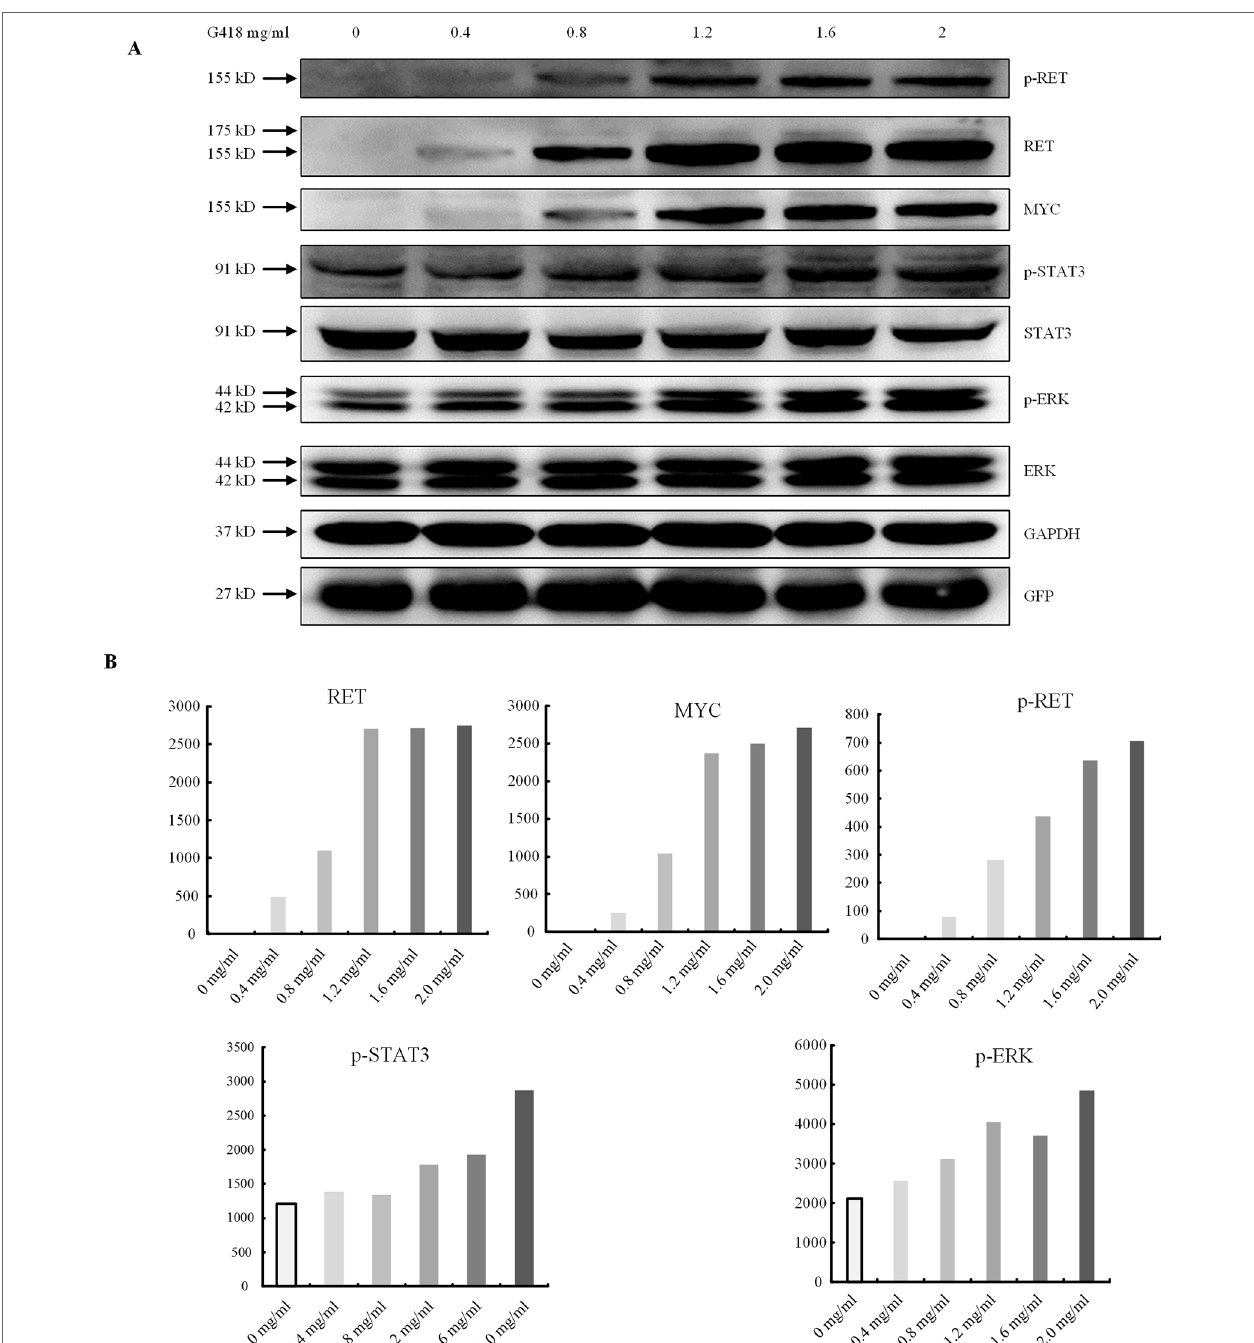
FIGURe 5 | Premature termination codon rescue with G418. (a) The dose-dependent effect of read-through rescue of p.Y263X with G418 was assessed using western blotting. Values were normalized using GFP and GAPDH. GAPDH was used as the internal control. (B) Cells were transfected with plasmids carrying the p.Y263X nonsense mutant and then treated with different doses of